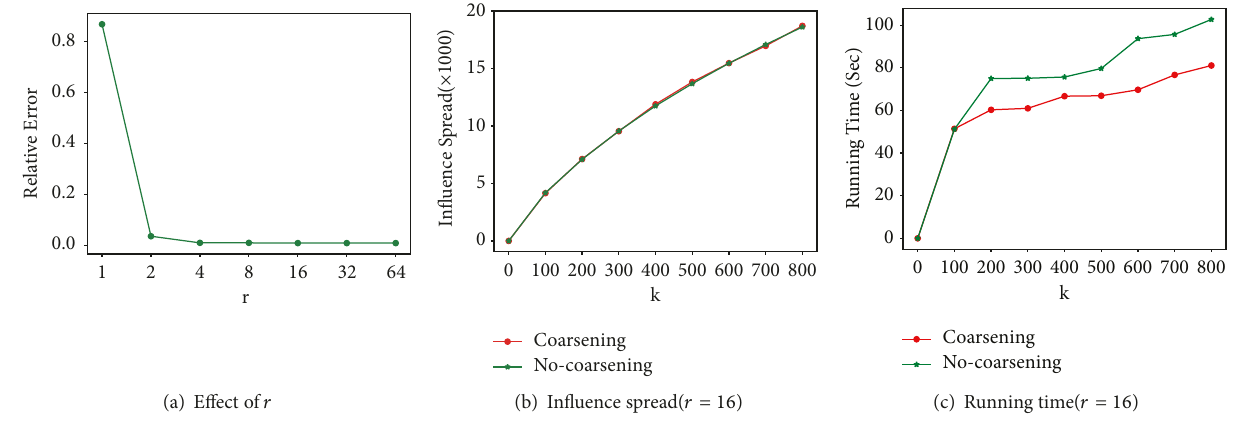
Figure 5: Effect when using